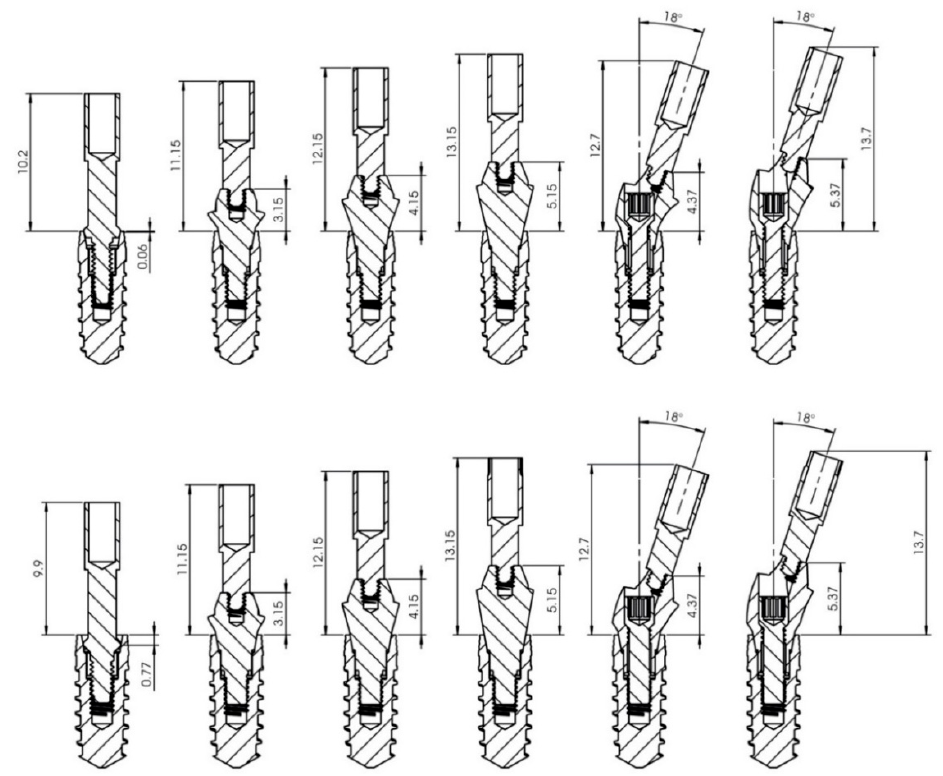
Figure 1. Abutment implant assembly, Permanent. Section 00, 3:1 scale. Implant Stability Quotient (ISQ) measurement sequence: directly on the implant; straight, 1, 2, and 3 mm height abutments; angled, 2 and 3 mm height abutments, respectively.